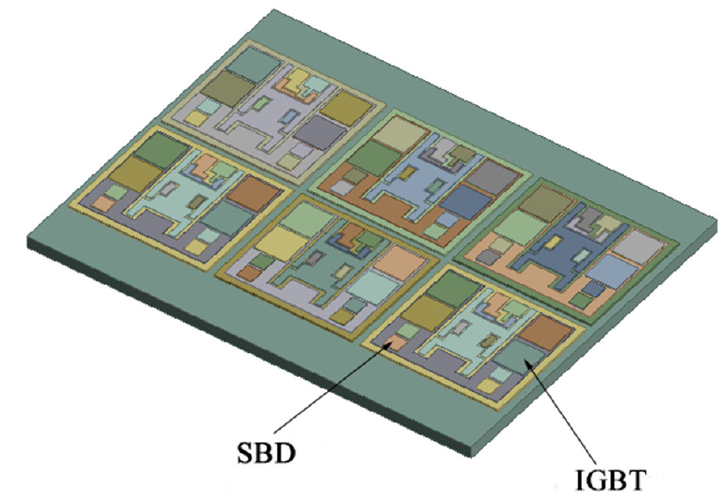
Micromachines 2022 , 13 , x